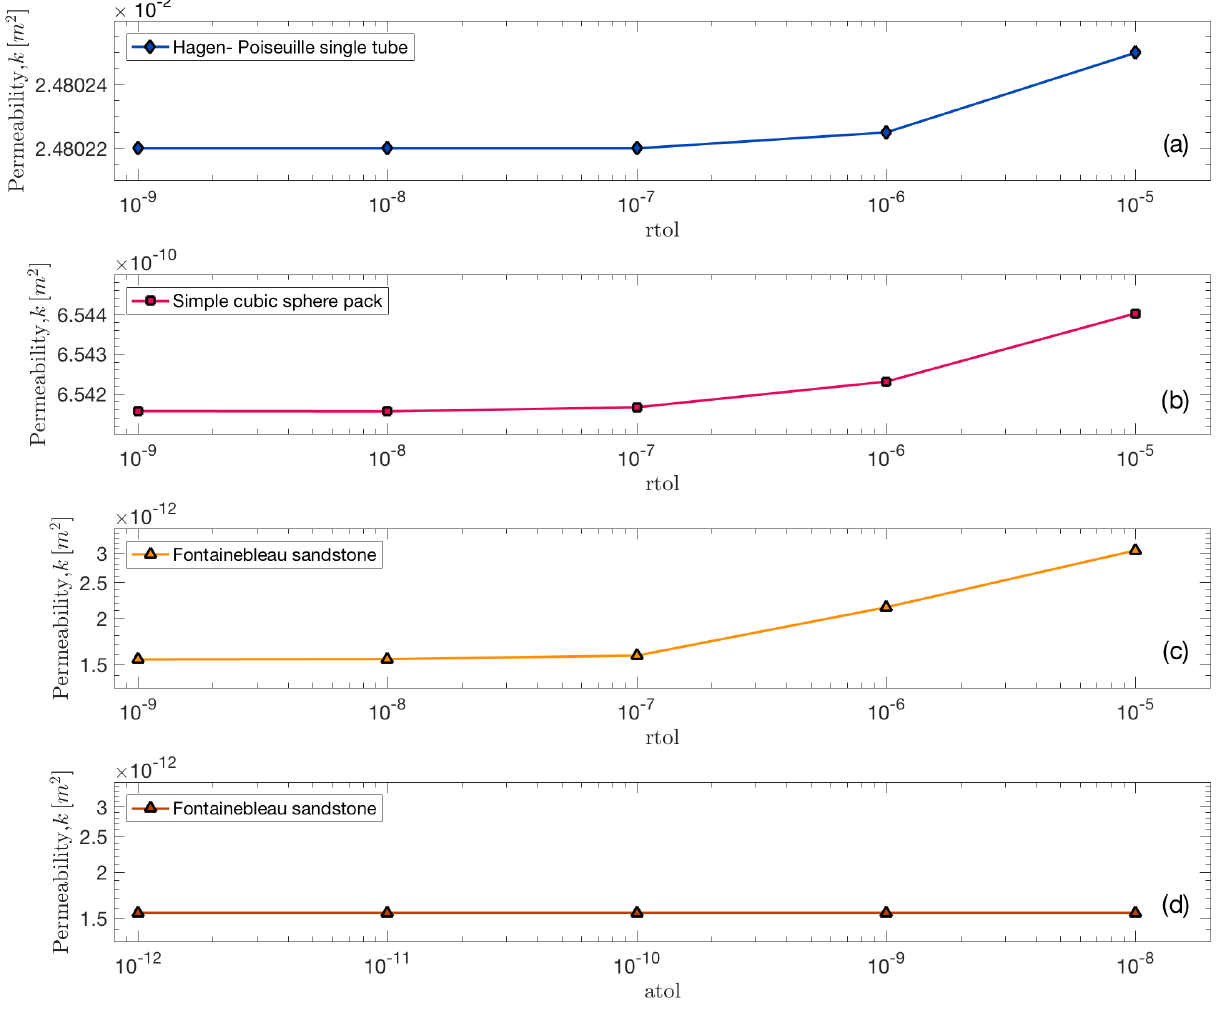
Figure A1. Results of simulations for (a) Hagen–Poiseuille single tube, (b) simple cubic sphere pack and (c, d) Fontainebleau sand- stone using different relative/absolute convergence